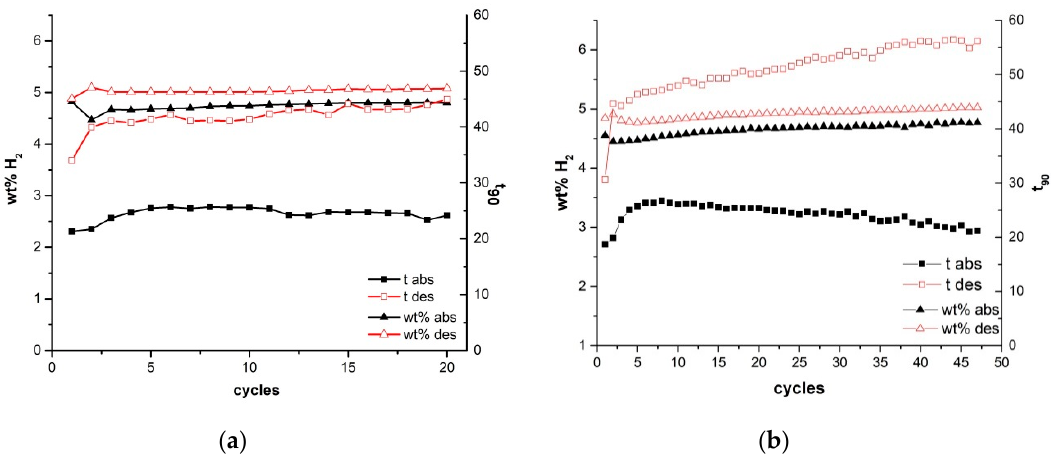
Figure 4. Hydrogen capacity vs. t 90 (time to reach 90 wt % of hydrogen total capacity). For MgH 2 –5Fe–5ENG pellet during ( a ) 20 and ( b ) 45 cycling.